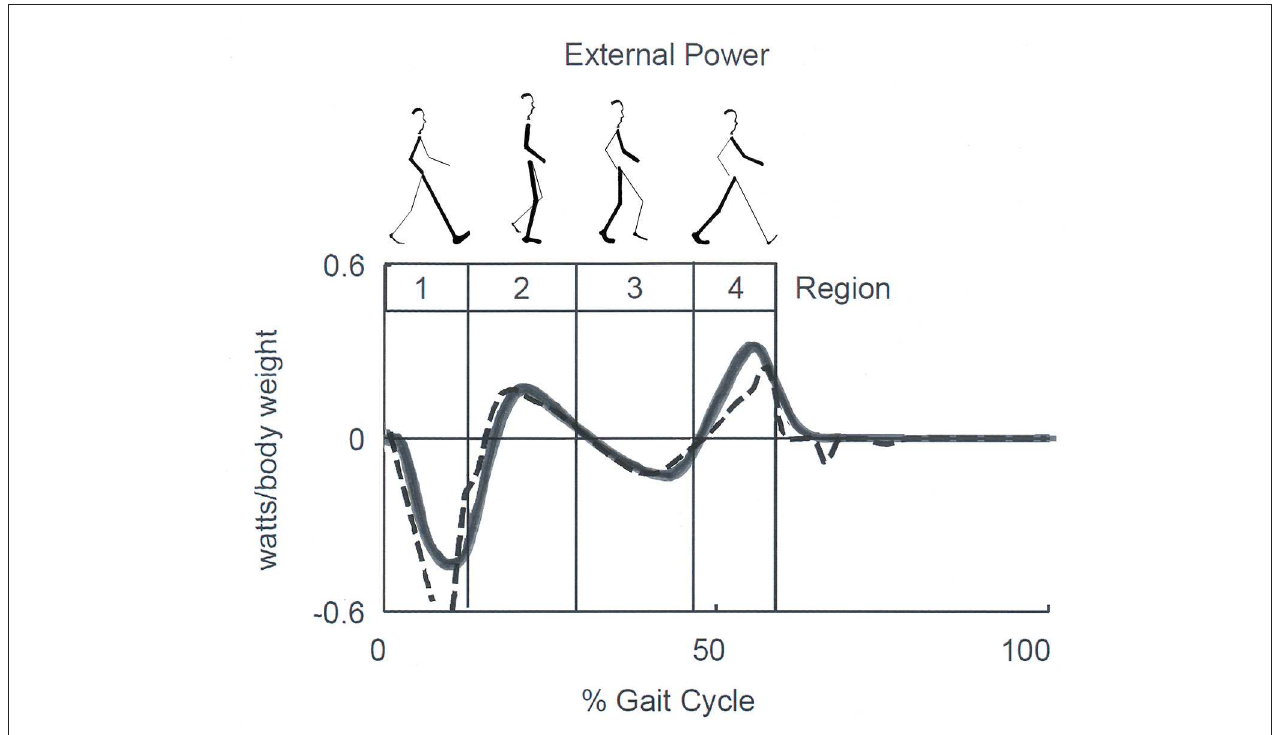
FIGURE 6 | Sketch of Neptune’s Regions of the step. Regions are defined by the zero crossing of the external power curve, which corresponds approximately to double support in Regions 1 and 4, and to the rise and fall of the center of mass (CoM) during single stance in Regions 2 and 3, respectively. Late Regions 3 and 4 correspond to the push-off phase according to other authors. Continuous and dashed lines correspond to experimental and model-simulated data. Adapted from Neptune et al. (58), used with